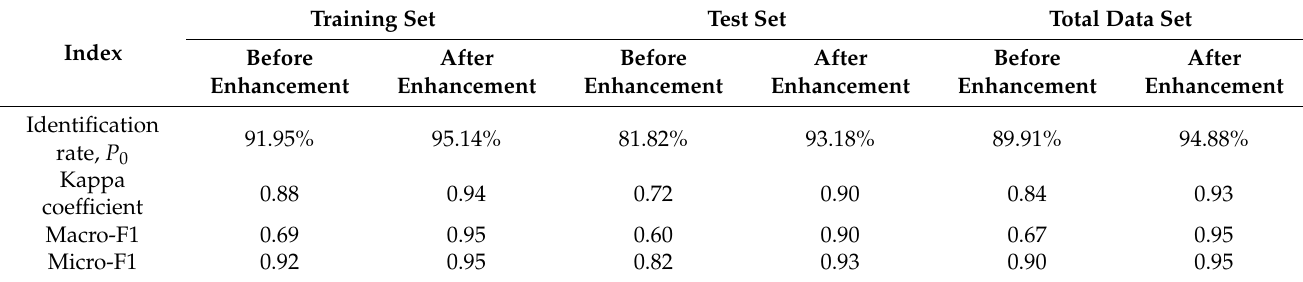
Table 8. Evaluation indexes of the model on different sample sets before and after data